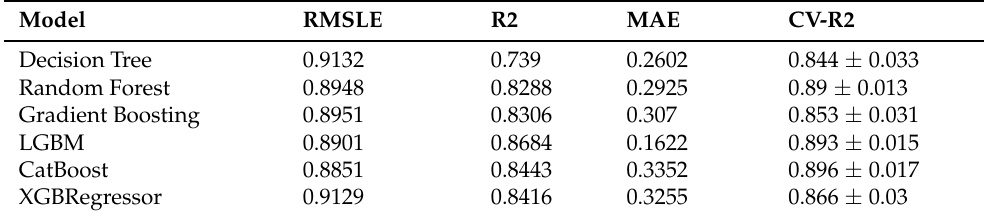
Table 10. Results of severity for the